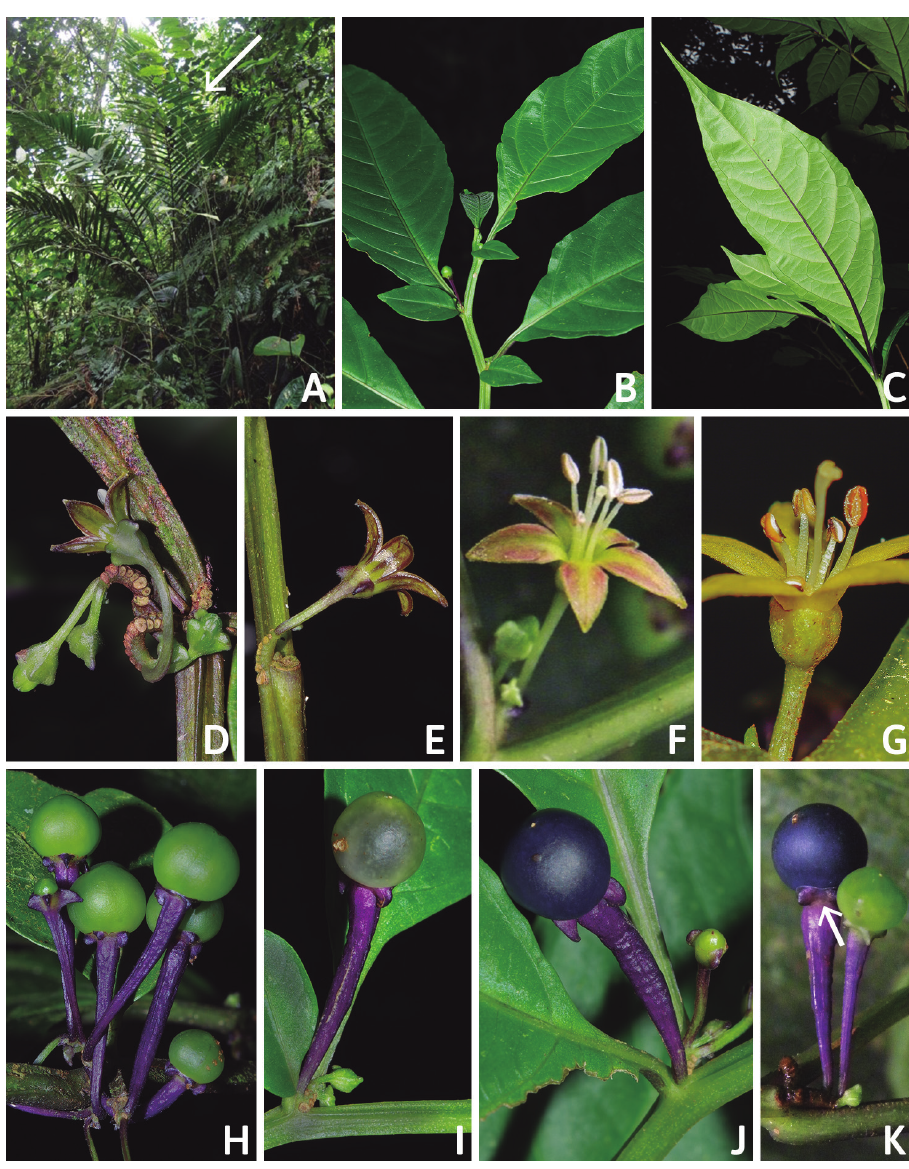
Figure 2. Capsicum regale Barboza & Bohs. A habitat B apical branch, showing anisophyllous leaf pairs C abaxial surface of leaf with purple main vein D forked inflorescence; note the scars of the deciduous flowers E flower, in lateral view, on a unbranched elongate inflorescence F, G Flowers with and without pigmentation respectively H–K various stages of fruit maturity, in K mature fruit showing the constriction between the pedicel and the berry (arrow) A–F, H–K from Orejuela et al. 3034 (photos by A. Orejuela, P. Gonzáles, and G. Barboza) G from Hoyos 127 (photo by L.